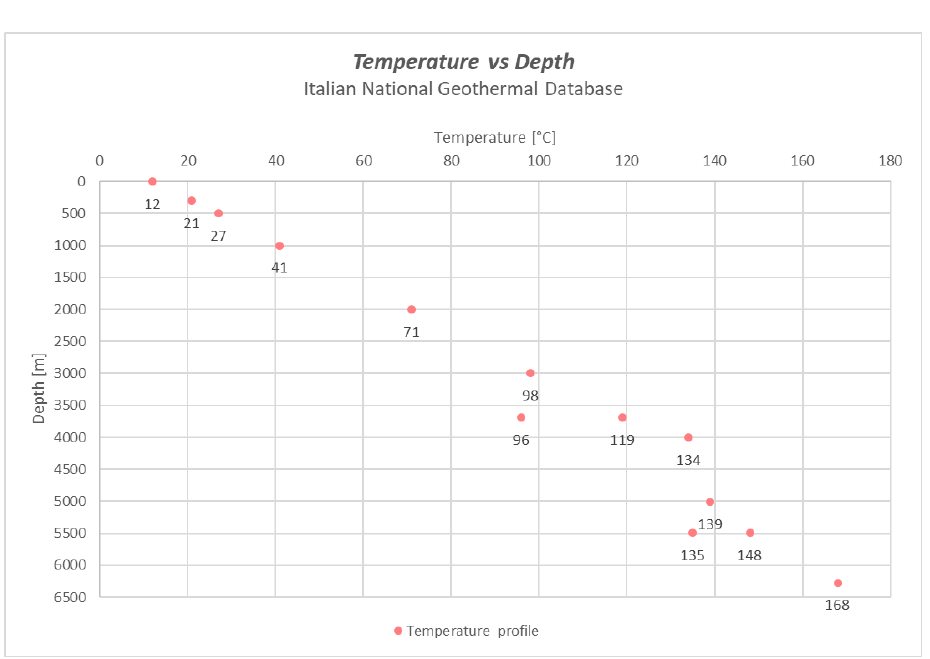
Figure 2. Temperature data visualisation for the Trecate4 hydrocarbon well: depth (m); temperature (°C).